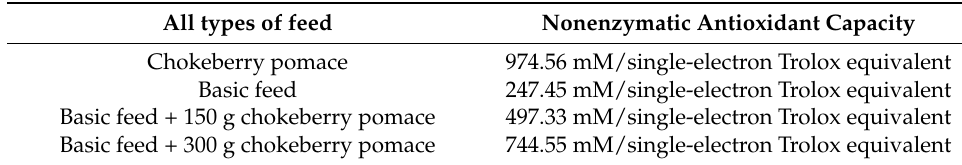
Table 9. Nonenzymatic antioxidants capacity in all types of